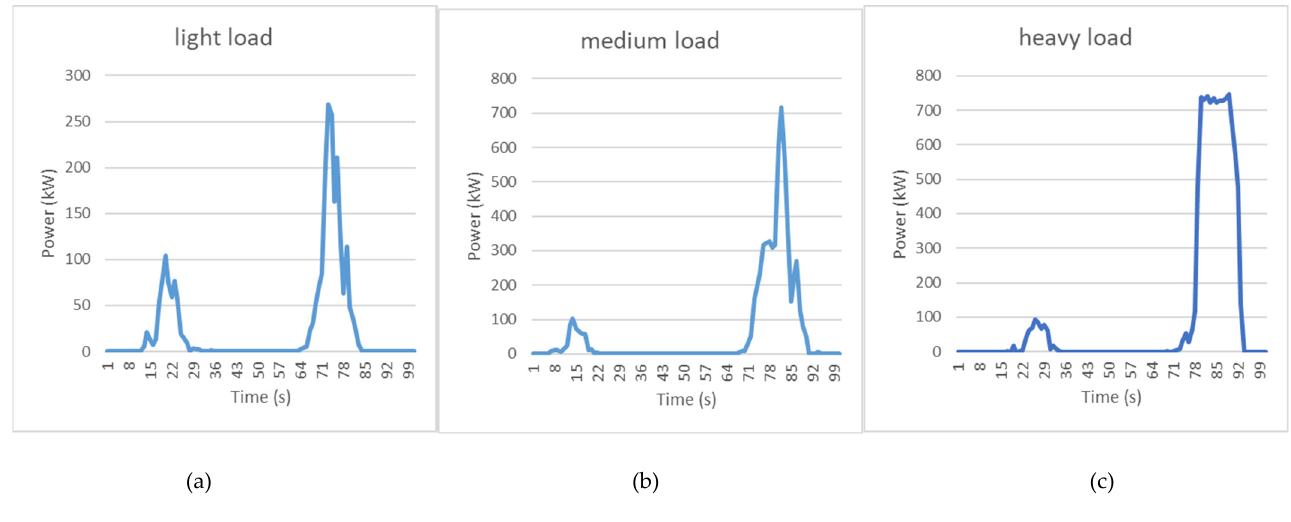
Figure 8. Energy consumption under different loads: ( a ) light load, ( b ) medium load and ( c ) heavy load